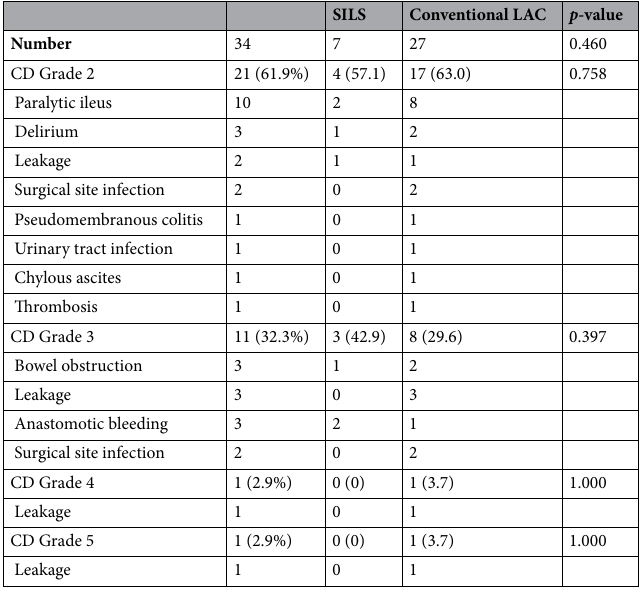
Table 6. Details of the postoperative complications of the 34 patients. CD Clavien-Dindo